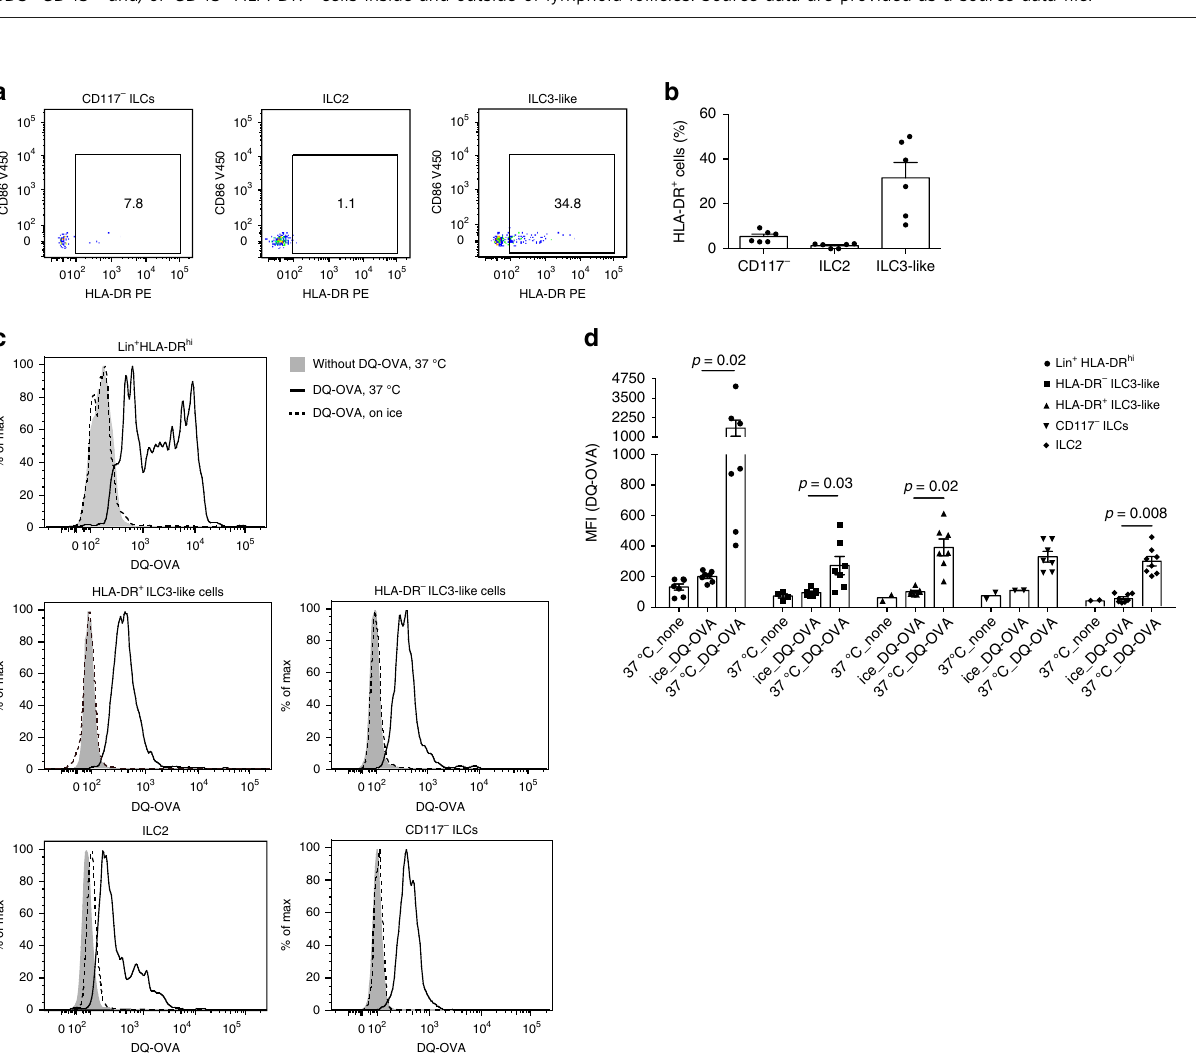
with CD3 + CD45 + and/or CD45 + HLA-DR hi cells inside and outside of lymphoid follicles. Source data are provided as a source data fi le.